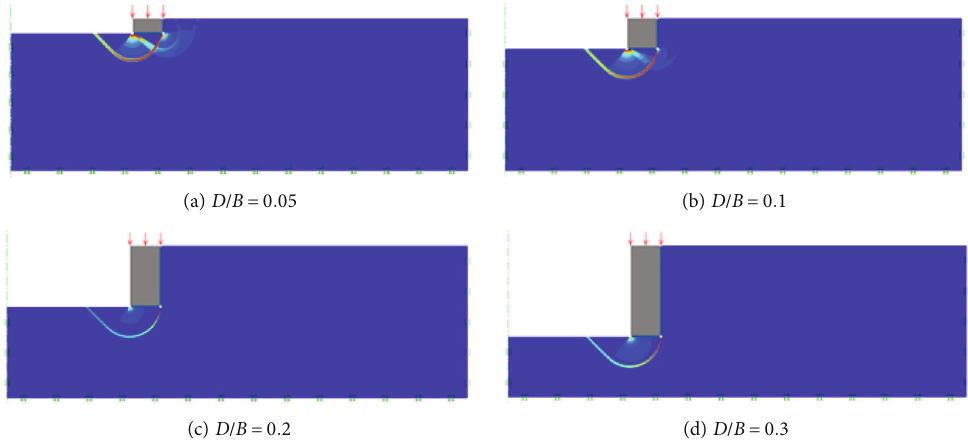
Figure 10: Failure patterns of the ring foundation with di ff erent embedment depths ( η = 0 : 8